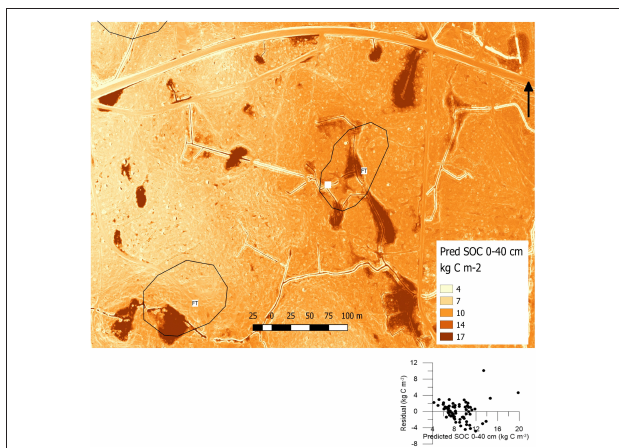
FIGURE 2 | SOC stock estimates (0–40cm) and residual plot (insert) from GLM upscaled with DEM 0.40cm and previously mapped peat area, (black line polygons: FT–signature for peat, ML–loamy till, GEUS 1:25.000). Equation: SOC, kg C m − 2 = 45.95 – 0.368*slope(degrees) – 0.951* elevation (m a.s.l.) – 503.2*sink depth (m) + 14.6* elevation*sink depth. Mean standard error of individual prediction (94 grid points) was 2.45kg C m − 2 (std 0.13,